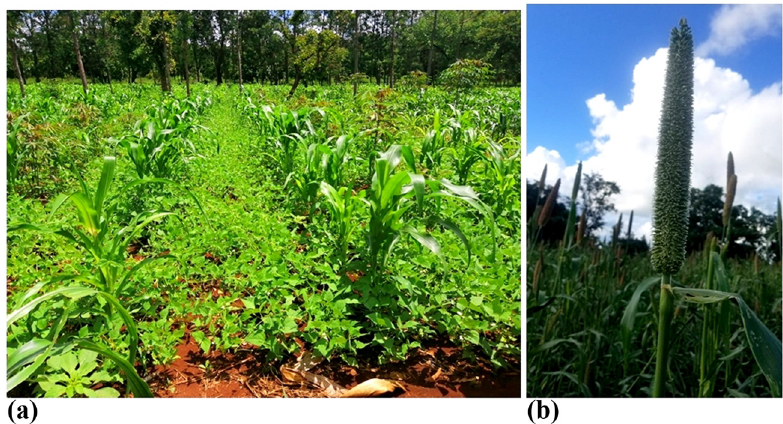
Figure 1: Family farming systems characterized by intercropping. Photograph ( a ) shows a farm in Kitui County with common bean and maize plants intercropped. Photograph ( b ) shows sorghum crop from Tharaka Nithi. Erratic rainfall occasioned by climate change has led to a rapid shift from maize to sorghum in many family farming systems in the arid agroecological zones of Kenya owing to its economic value and tolerance to water